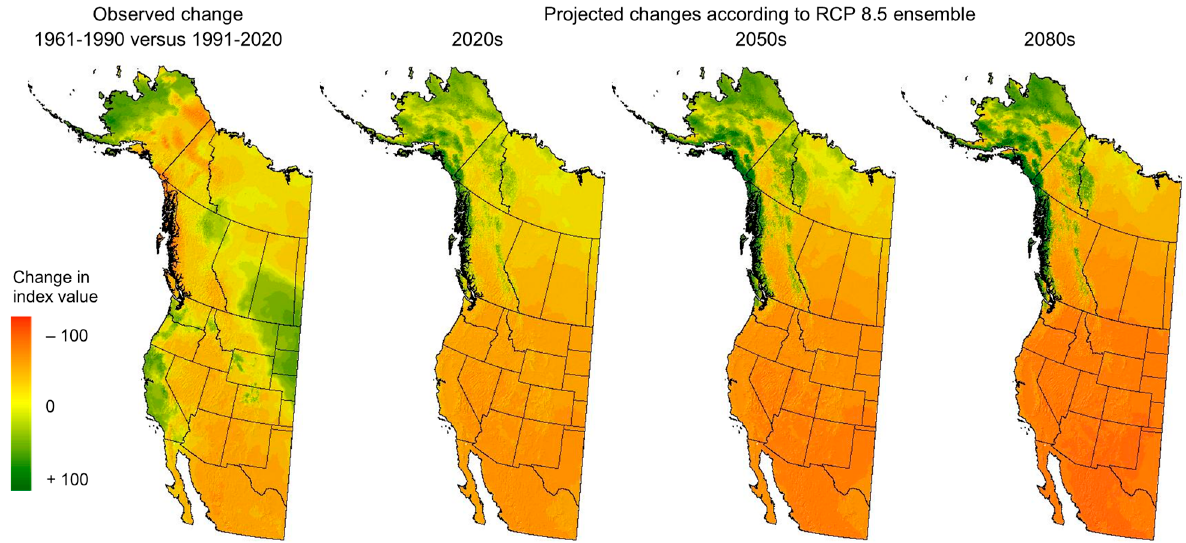
Figure 2. Observed and projected climate change, expressed through Hogg’s [23] climate moisture index (CMI). Observed changes are based on the CRU-TS v4 historical dataset [31], processed with the ClimateNA software package [29]. The projections shown are for a 13-model CMIP6 average ensemble [15], also included in the ClimateNA software. Changes in CMI as a combined effect of precipitation and temperature changes are visualized in Appendix A, Figure A1.